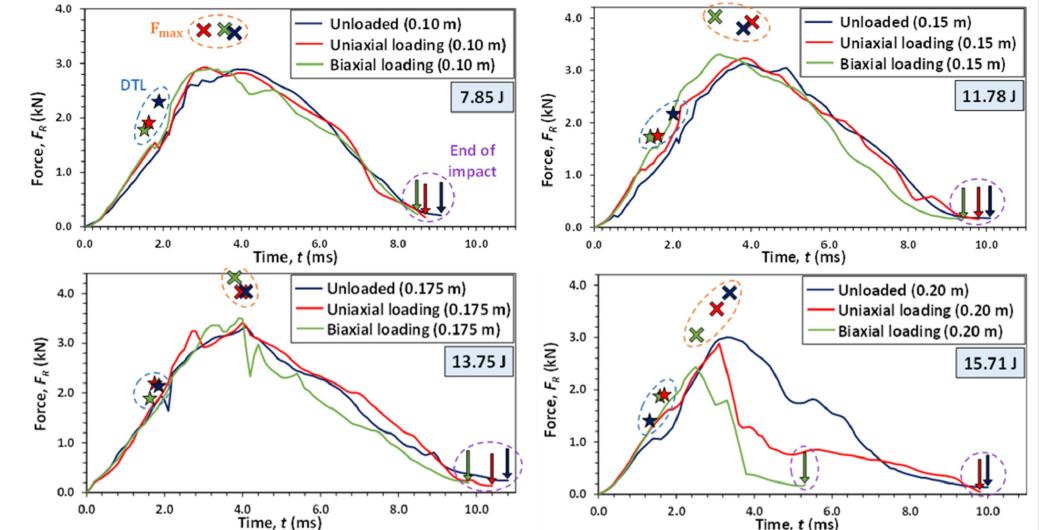
Figure 14. Force–time plot for impact energies of 7.85, 11.78, 13.75 and 15.71 J preloaded in three states: unloaded, uniaxial and biaxial, using a five-point moving average trendline. The stars, crosses and arrows indicate the damage threshold level (DTL), maximum force ( F max ) and the end of the impact event (impact duration),